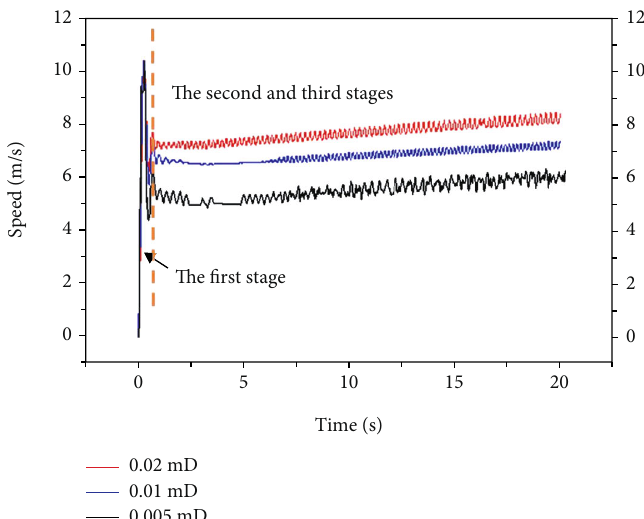
Figure 6: In fl uence of matrix permeability ( k ).